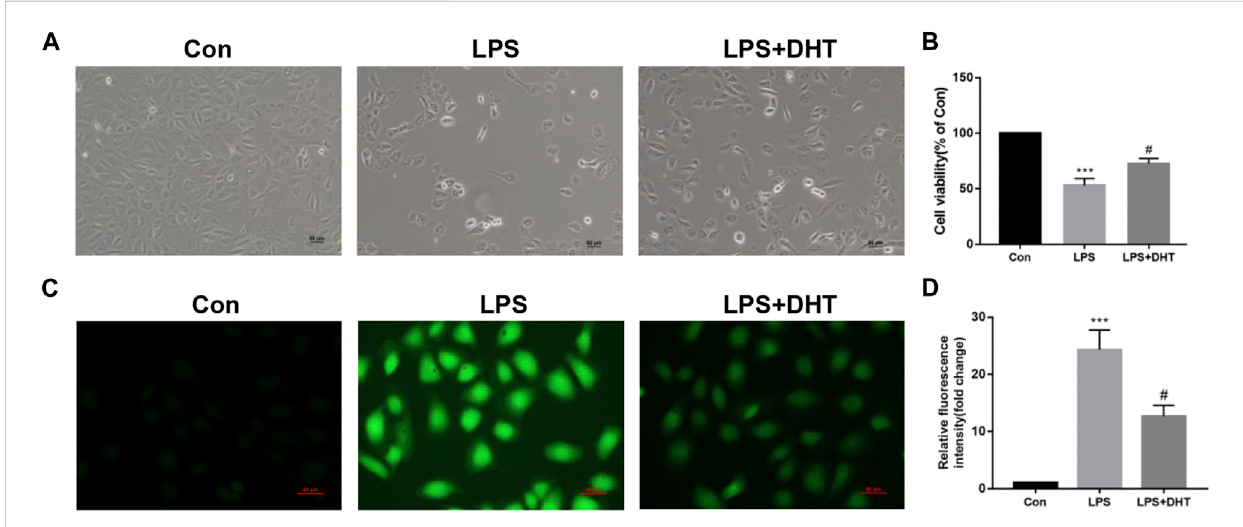
FIGURE 6 Effect of DHT on cell viability and oxidative stress in LPS-induced HK-2 cells. (A) Representative phase contrast images of HK-2 cell morphology in each group. Scale bars: 50 μ m. (B) Cell viability was determined using a CCK-8 assay (n = 3). *** p < 0.001 vs. Con, # p < 0.05 vs. LPS. (C) Representative image of ROS measured by fl uorescence microscopy in each group. Scale bars: 50 μ m. (D) Quantitative data of ROS fl uorescence intensity in HK-2 cells (n = 3). *** p < 0.001 vs. Con, # p < 0.05 vs.